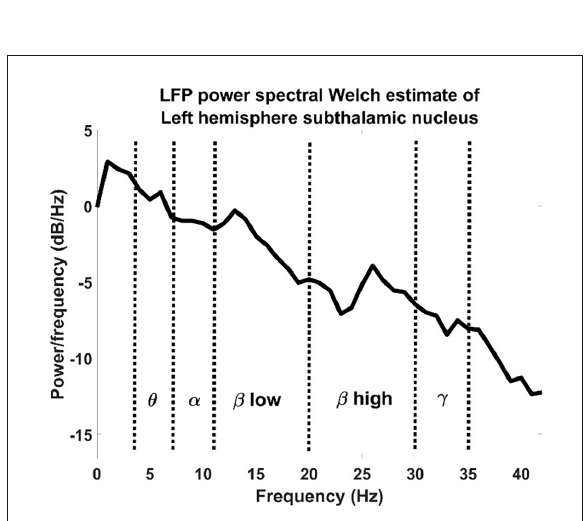
FIGURE2 LFP power spectral Welch estimate of an LFP recorded from a left hemisphere subthalamic nucleus divided by physiological bands.